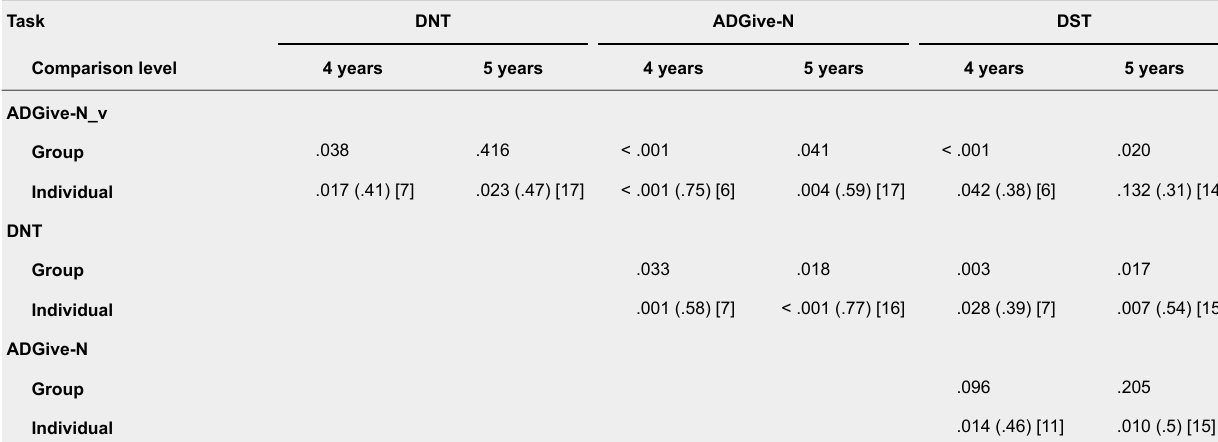
Comparisons Between Tasks on Group Level and Individual Level